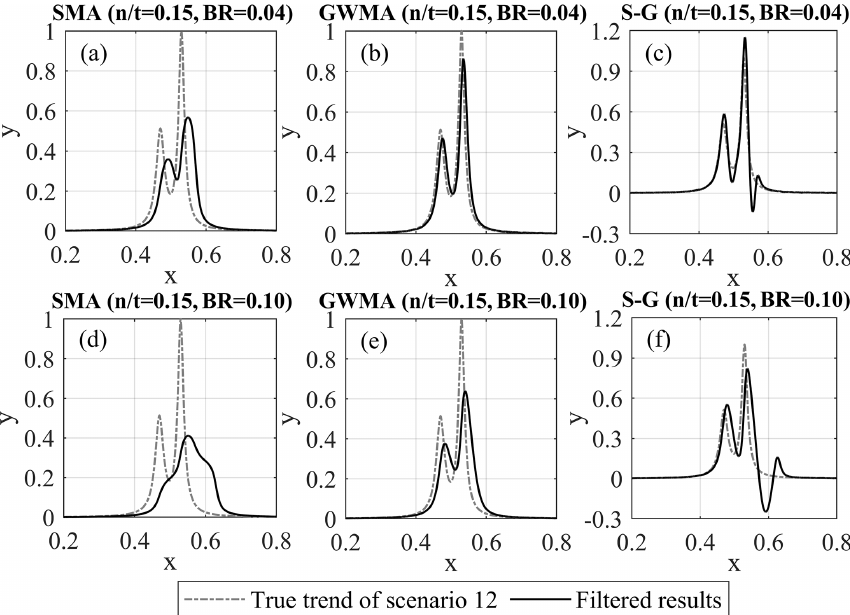
Figure 9. Filtered results of Scenario 12 with scatter using SMA (a,d) , GWMA (b,e) , and S-G (c,f) at bandwidth ratios (BRs) of 0.04 (a–c) and 0.10 (d–f) .